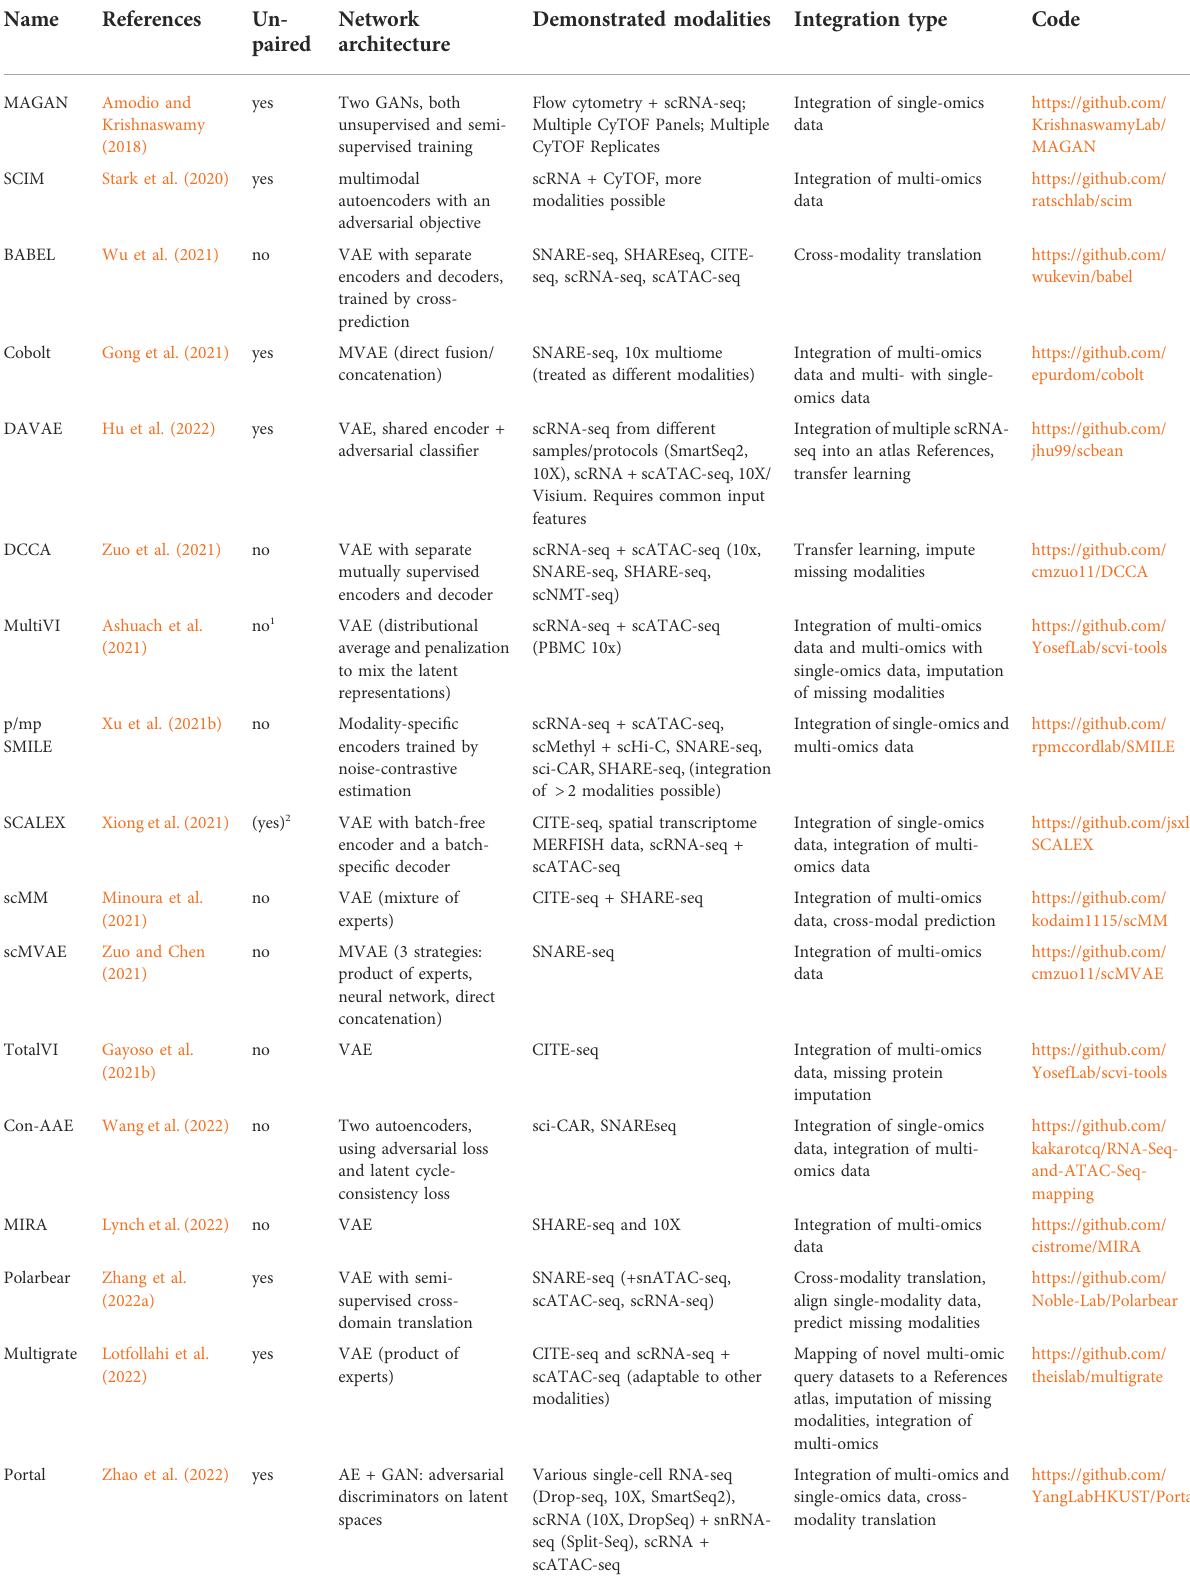
TABLE 1 Overview of recently published deep learning-based methods to integrate single-cell multi-omics data. 1 Only for mapping single-omics to multi-omics; 2 Only when converting peaks to activity